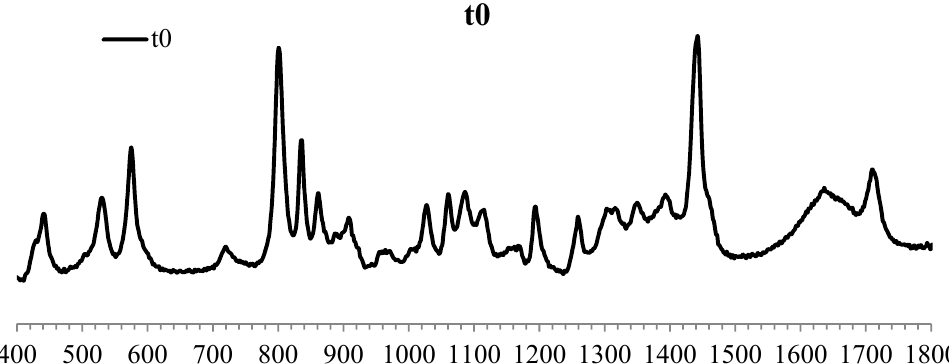
Figure 1. Raman spectra of 1M GA incubated at the initial time (t0), room temperature, and 40 ° C for 8 weeks.